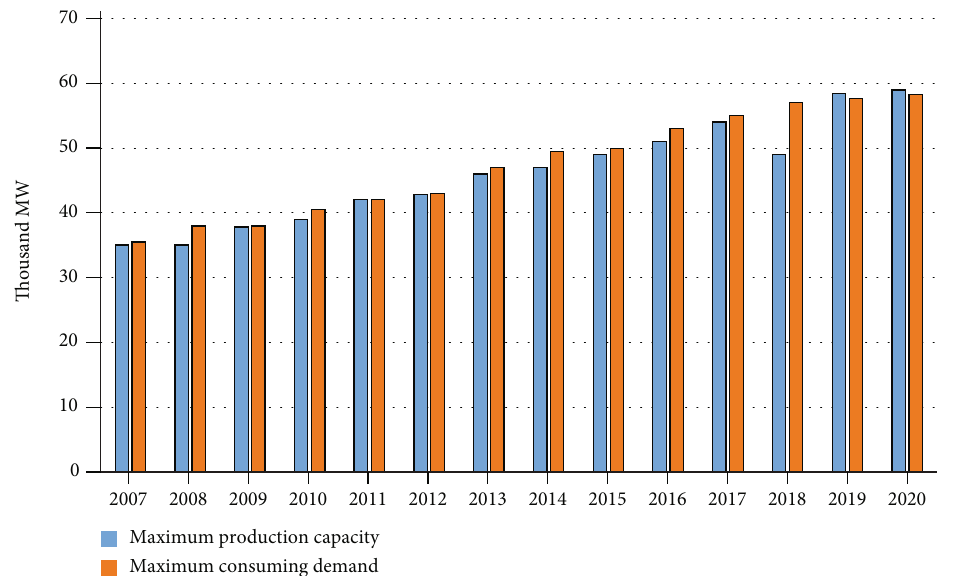
Figure 1: Maximum production capacity and consuming demand in network peak time in Iran. Extracted from the Iran Grid Management Company (IGMC)